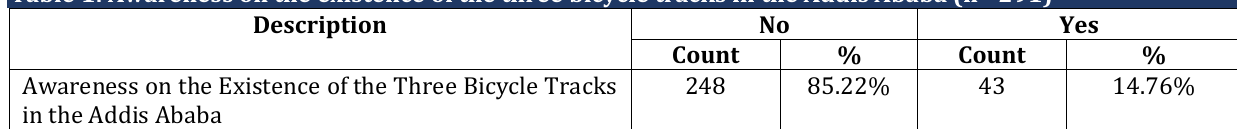
Table 1: Awareness on the existence of the three bicycle tracks in the Addis Ababa (n =291) Description No Yes Count % Count % 248 85.22% 43 14.76%